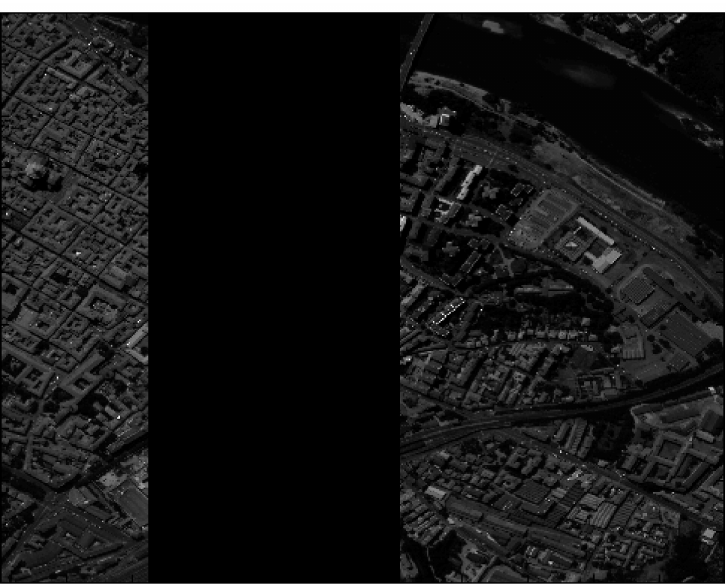
Figure 2. Sample band of Pavia Center